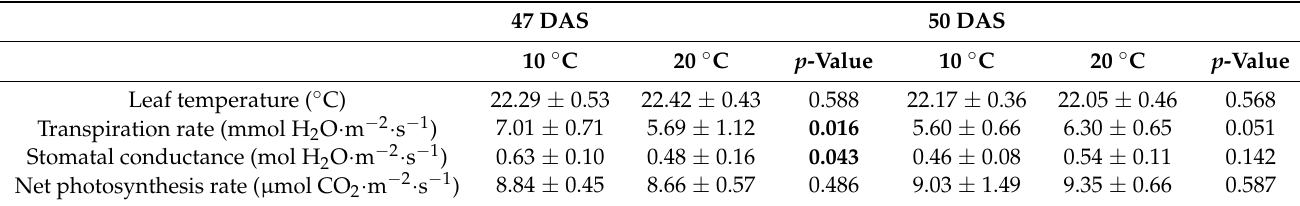
Table 2. Effect of root temperature treatment on leaf temperature, transpiration rate, stomatal conductance and net photosynthetic rate of Chinese broccoli at two dates (47 DAS and 50 DAS) after treatment started in Exp-2. Significant differences ( p < 0.05) were indicated in bold.